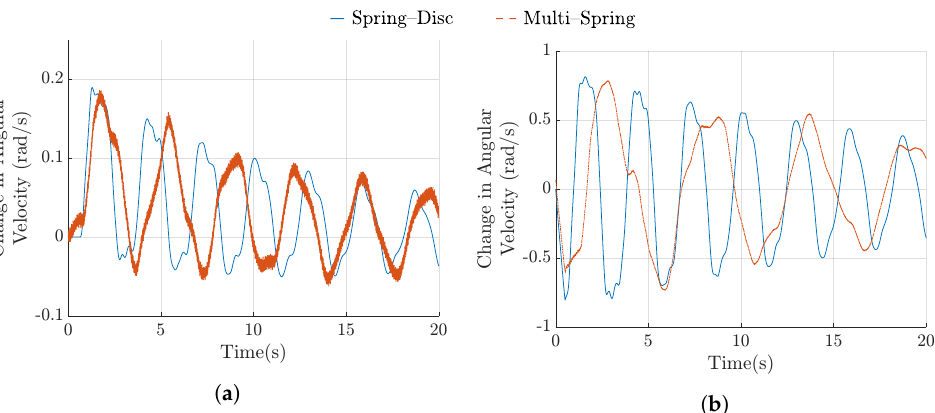
Figure 17. Response of angular velocity of the rotor to changes in torque and axial tension for the spring − disc and multi − spring models, TRPT length 30 m, wind speed of 8 m/s. ( a ) Response to a change in torque; ( b ) Response to a change in axial